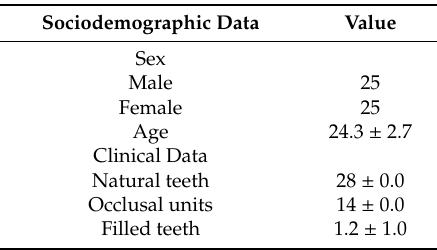
Table 1. Sociodemographic and clinical variables of sample size ( n = 50). Data values are expressed as the number of participants for sex and mean and standard deviation (SD) for all other values.